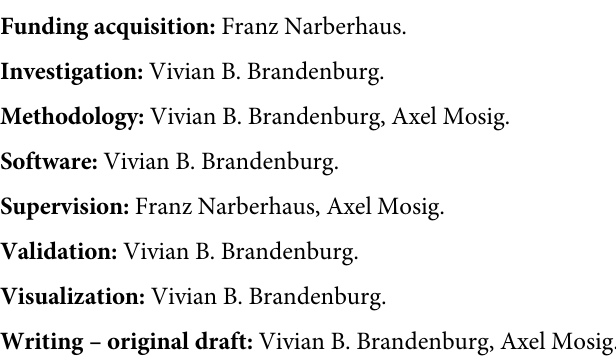
S8 Fig. Impact of sequence and structure on terminator and tRNA recognition of LSTM models. (A) Relative activation impact of terminator sections on LSTM models. Random mutations were introduced in each of the 7 sections of the transcription terminators. The rela- tive activation impact on the models is calculated from the difference between the model out- put corresponding to the original sequences and sequences with random nucleotide mutations in half of all nucleotides per section. (B) Relative activation impact of the base pairings in the stem of terminators on LSTM models, for a growing number of mutated base pairs. The rela- tive activation impact is calculated from the difference between the model output correspond- ing to mutations which retain or disrupt the pairing state in the stem structure. (C) Relative activation impact of the base pairings in the stems of tRNAs on LSTM models, for a growing number of mutated base pairs. The relative activation impact is calculated from the difference between the model output corresponding to mutations which retain or disrupt the pairing state in the stem structure. (A), (B): For k = 1, . . . , 10 and n 2 {93, 84, 102, 91, 94, 92, 93, 113, 99, 92} (C): For k = 1, . . . , 10 and n 2 {198, 203, 194, 202, 201, 201, 199, 201, 194,